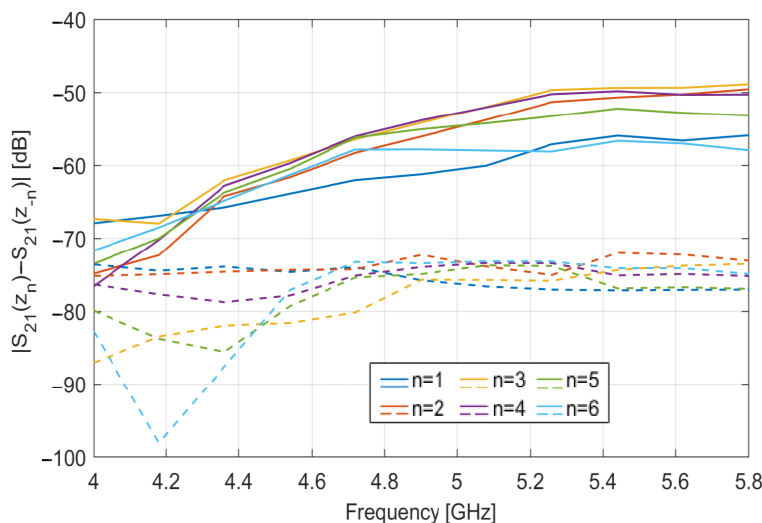
Figure 12. |S 21 (z n ) − S 21 (z − n )| (in dB) vs. frequency simulated when the OUT is displaced of +5 mm along the y -axis: OUT with an 8 mm glass inclusion (solid lines); OUT free of inclusions (dashed lines).